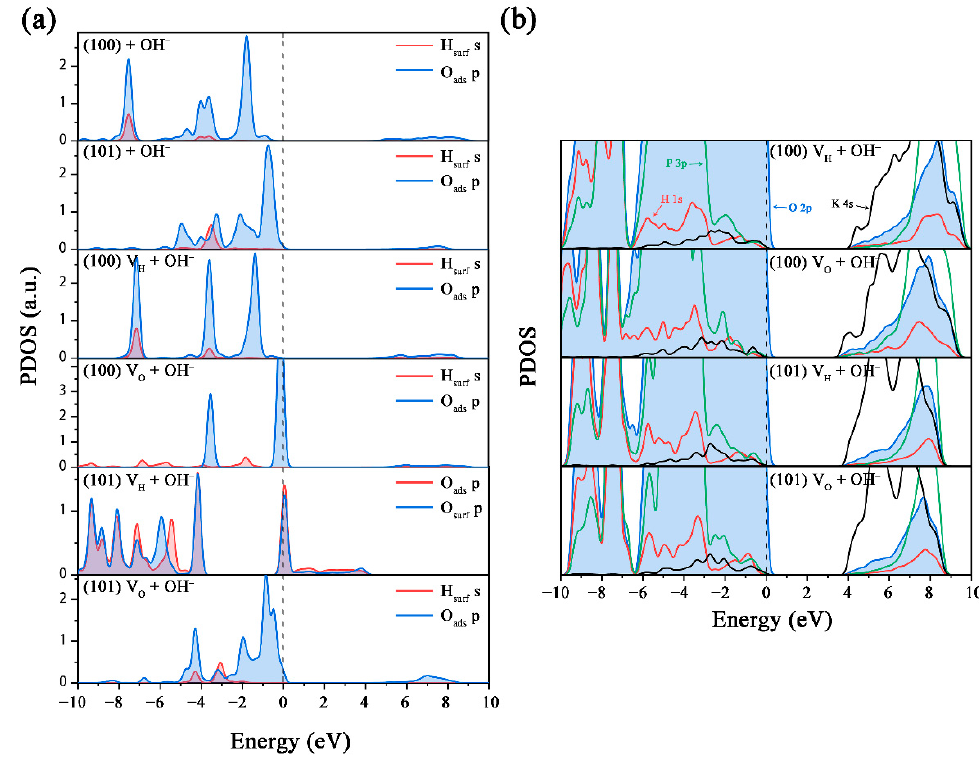
Figure 7. ( a ) Partial density of states of the adsorbed OH − ions and the adjacent surface atoms on the (100) and (101) surfaces; ( b ) partial density of states of the OH − adsorbed (100) and (101) surfaces with V H and V O defects.